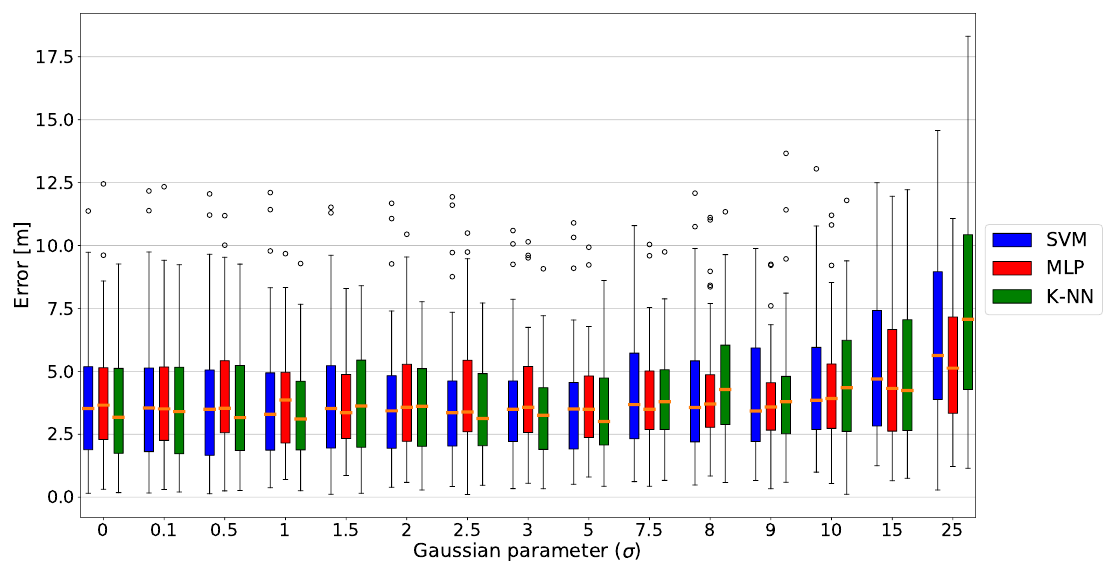
Figure 11. Error box plots for the three fingerprinting algorithms as a function of the standard deviation of the Gaussian noise in Environment